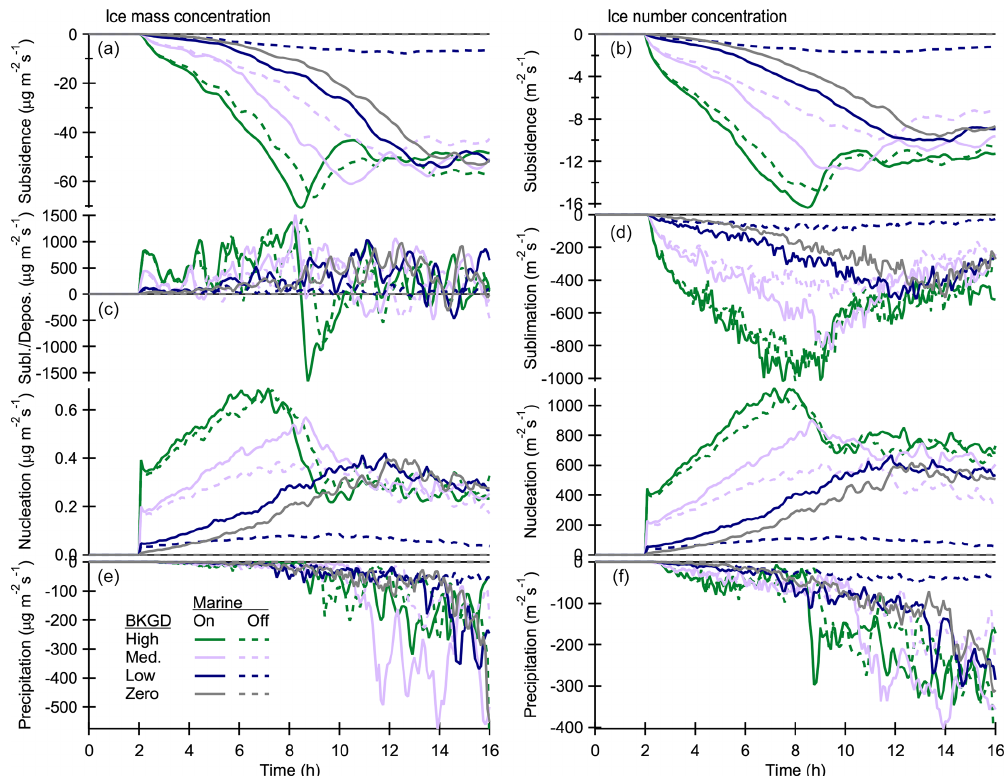
Figure 6. The four mechanisms (subsidence, water vapour sublimation and deposition, nucleation, and precipitation) affecting ice mass (a, c, e) and number (b, d, f) concentrations. Simulations are initialized with different background INP concentrations and marine INP emissions are switched on (solid lines) or off (dashed